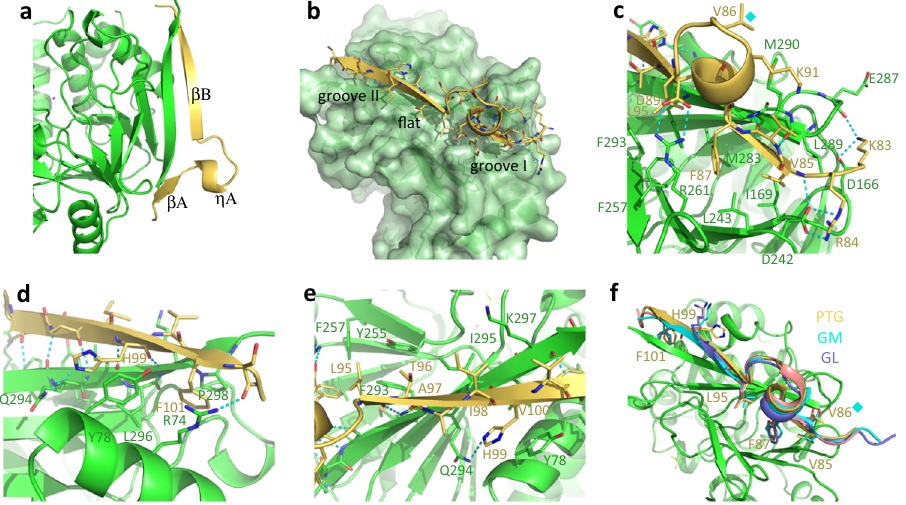
Fig. 2 | Crystal structure ofPP1 in complex with the PTG peptide 81 – 107. a The PTG peptide (yellow) organizes in two β -strands (and an intervening 3 10 helix) extendingthePP1(green) β sheet. b ThepeptideperfectlyadaptstothePP1surface fi lling the two grooveswith hydrophobic side chains. c Detailed interactions ofthe PTG RVVF region with the fi rst PP1 groove. Val86 substituting the GM and GL phosphorylated serine is marked with a cyan diamond. d Detailed interactions of